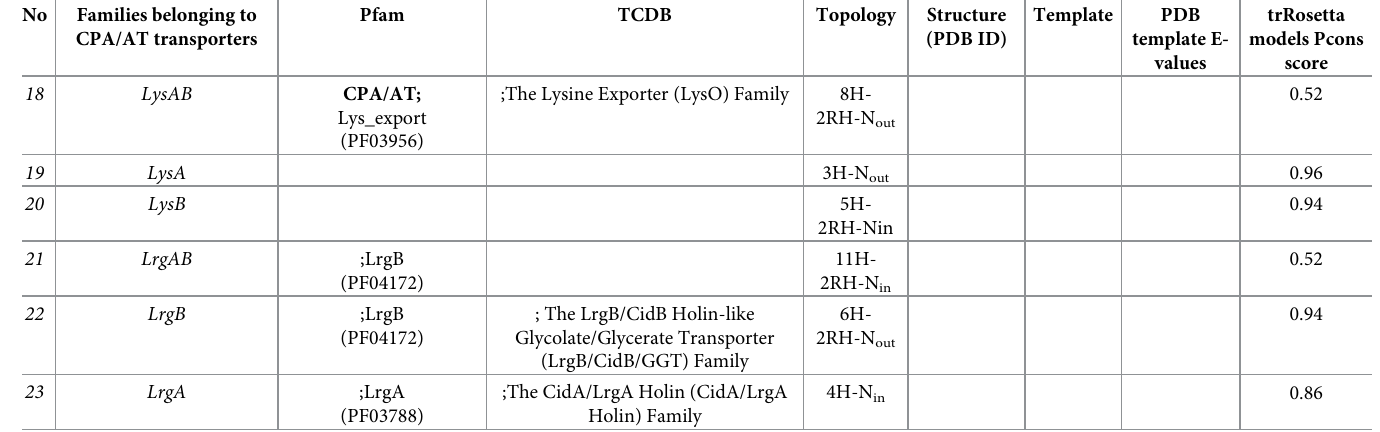
The Reentrant-helix-reentrant fold-type